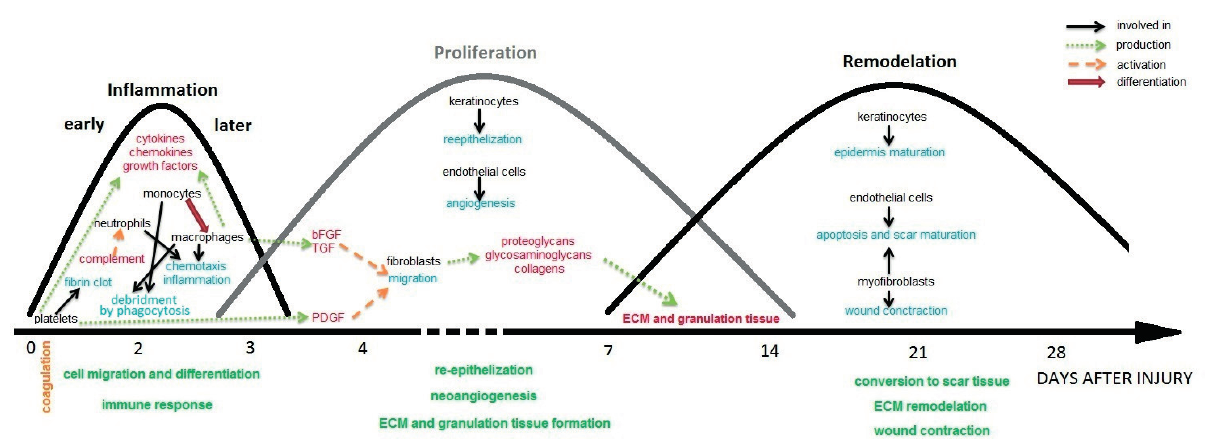
Fig. 1. Phases of wound healing: processes, cells and factors involved. FGF – basic fibroblast growth factor; ECM – extracellular matrix; PDGF – plateled-derived growth factor; TGF – transforming growth